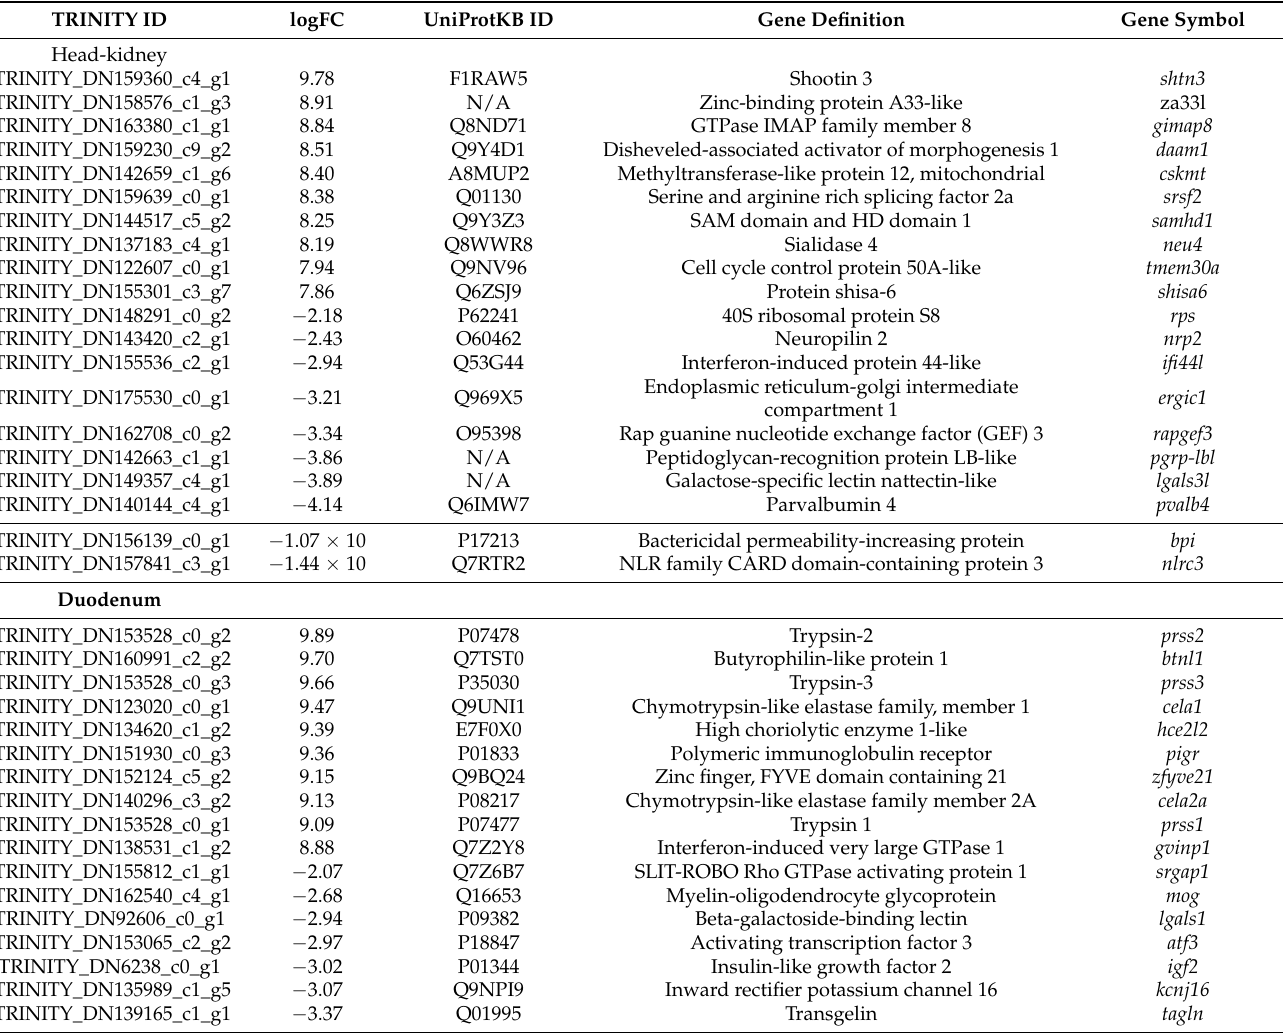
Table 1. Top 10 most upregulated and top 10 most downregulated differentially expressed genes between LPS and sham-injected fish in each tissue (head-kidney, duodenum and